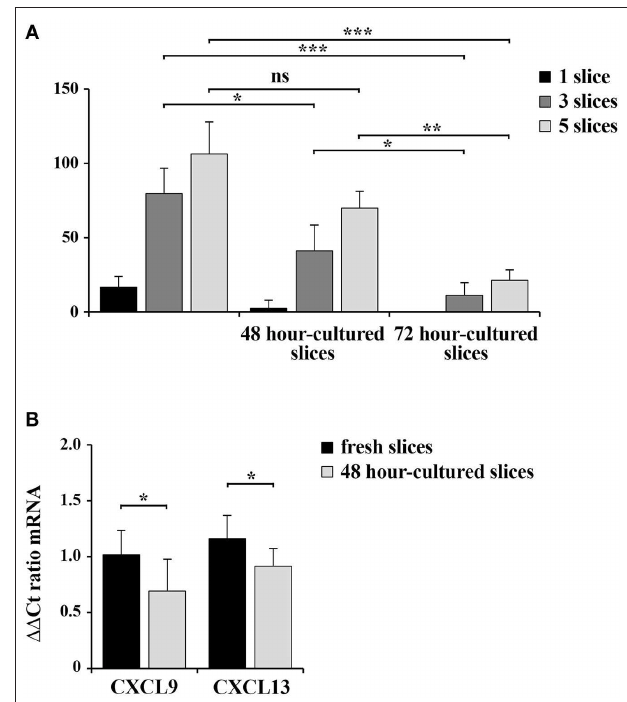
FIGURE 6 | 48 h-cultured spleen slices show a slight decrease in RNA yield and quality. (A) RNA concentration in samples from 1, 3, or 5 spleen slices homogenized in RNA extraction buffer either immediately after cutting or after in vitro culturing for 48 and 72h. The measurement of RNA concentration was performed using QIAxpert System (Qiagen). (B) Quantitative RT-PCR analysis of CCL19 and CXCL13 mRNA in samples from 5 spleen slices homogenized either immediately after cutting or after in vitro culturing for 48h. The relative gene transcript abundance was determined on triplicate samples using the ddCt method. Gapdh was used as housekeeping gene. Mean ± SD. Student’s t -test; *** p ≤ 0.001; ** p ≤ 0.01; * p ≤ 0.05.